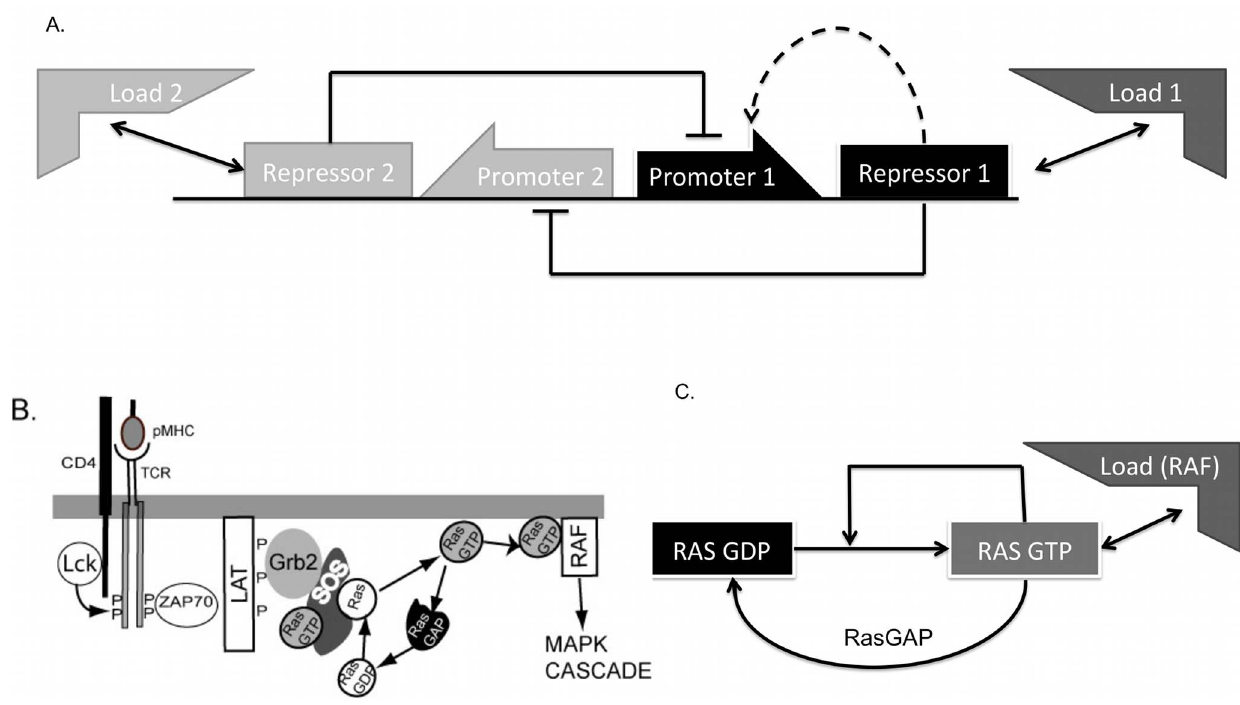
Figure 1. Schematic diagram of the circuits studied in this paper. (A). The basic toggle switch is the network shown without the dotted line. Repressor 1 represses the production of Repressor 2 and vice versa. The dotted line denotes a positive feedback motif found in some natural circuits. (B). A cartoon of part of the MAPK activation pathway in T lymphocytes, adapted from [29], showing the role of Ras activation. Signals from peptide- MHC complexes are received at the TCR and lead to phosphorylation of the cytoplasmic chains of the TCR by the Src kinase, Lck. This recruits the kinase ZAP70 which trans-autoactivates and phosphorylates a scaffold called LAT, which recruits Grb2 and SOS to the plasma membrane. SOS activates Ras as as shown. (C) A simplified model of the Ras switch. RasGDP transforms into RasGTP via the enzyme SOS. However the catalytic rate of SOS increases when bound to RasGTP. This sets up an autocatalytic positive feedback. RasGTP is deactivated by enzymes called RasGAP’s (among